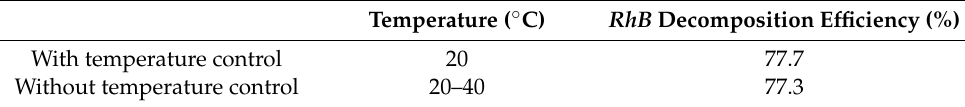
Table 1. Effect of temperature on RhB decomposition efficiency at pH 4 and FeCl 2 5 mg/L.